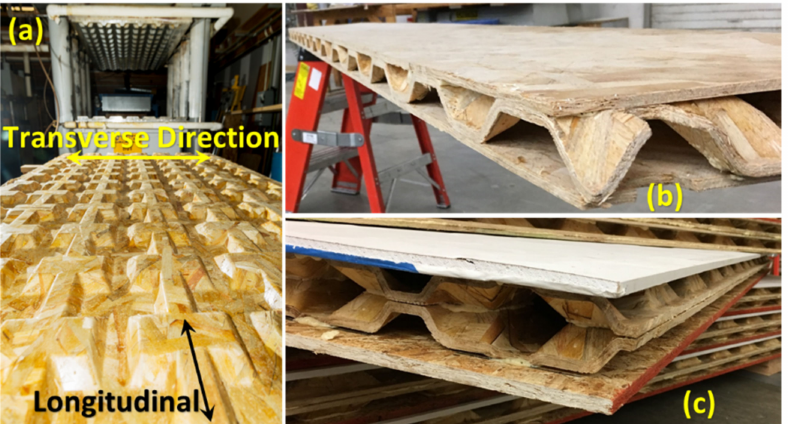
Figure 1. ( a ) Full size biaxial corrugated panel used as a core to fabricate ( b ) one-layered ( c ) two- layered core sandwich panels.